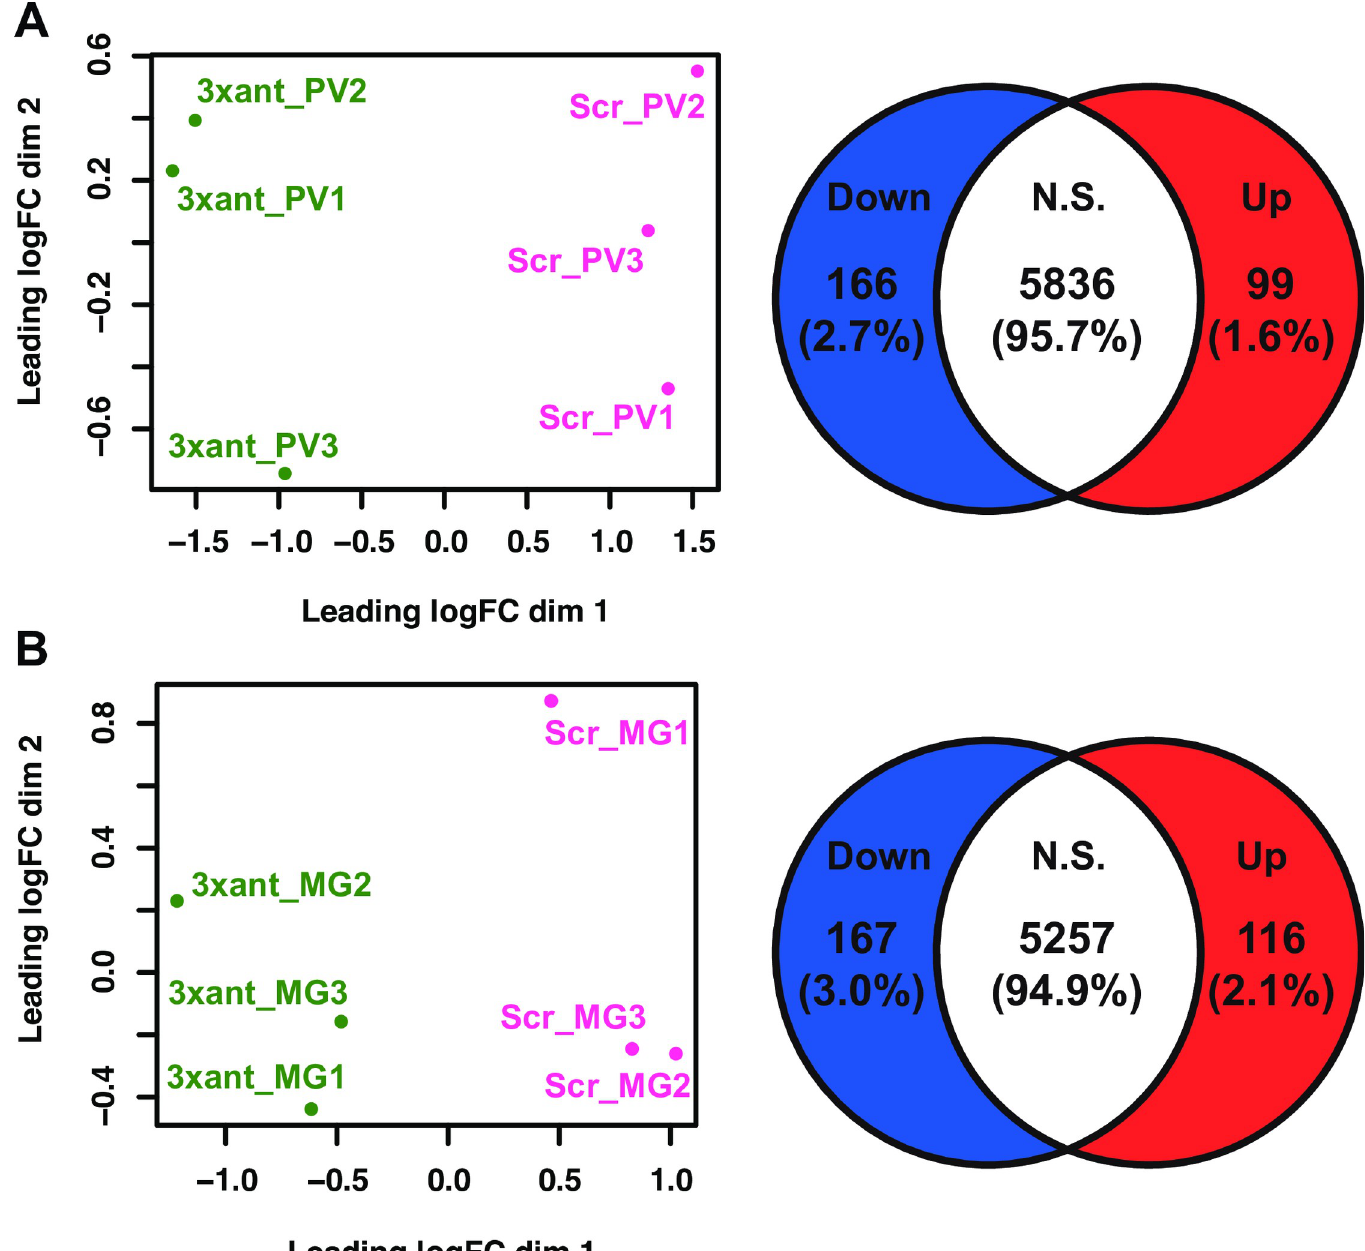
Fig 3. Overviews of transcriptome profiles in Gmm 3xant- miR275 compared to Gmm Scr-275 flies. (A) cardia and (B) midgut transcriptome profile overview. Left panel: MDS plots display the overall gene expression patterns among the samples and between the treatments. Right panel: Venn diagrams show the number of downregulated (blue), upregulated (red) and not significantly different (white) genes in (A) cardia and (B) midgut. Genes were considered DE if they exhibited an FDR value < 0.05.